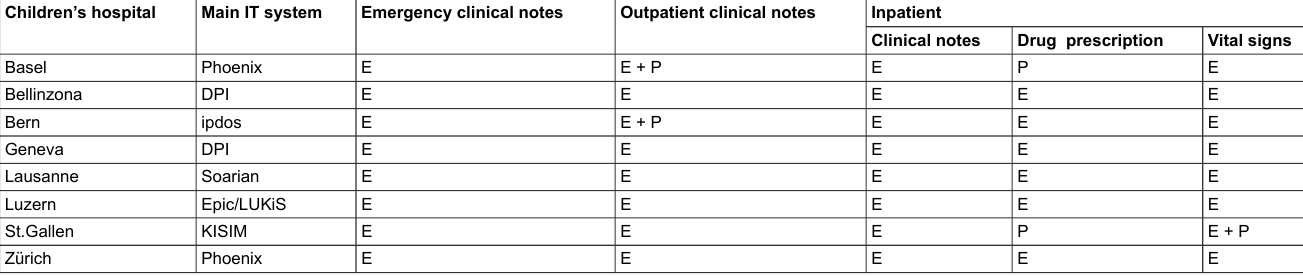
Table 1: Electronic health records systems used in Swiss children’s hospitals and digitalization of clinical